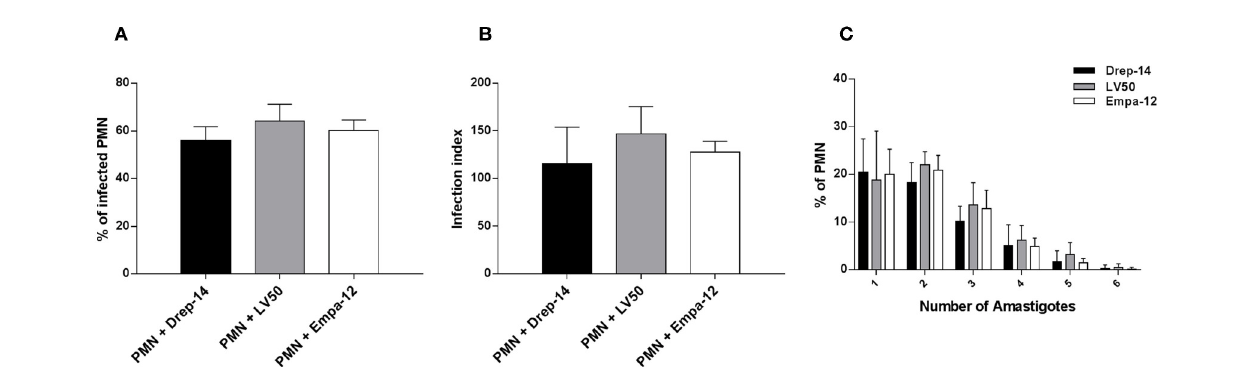
FIGURE 1 | Leishmania infection of PMNs. Human neutrophils were infected with Leishmania promastigotes (MOI of 10) for 18h. Then, extracellular parasites were removed and the cells were fixed and stained with May-Grünwald Giemsa kit. (A) The percentage of infected PMN, (B) the infection index and (C) the percentage of cells carrying the designated number of amastigotes were quantified using optical microscopy, by counting at least 100 neutrophils. Data are shown as the mean values from fourteen donors ± standard deviation (SD). Statistical comparisons were performed using the non-parametric Mann-Whitney test.